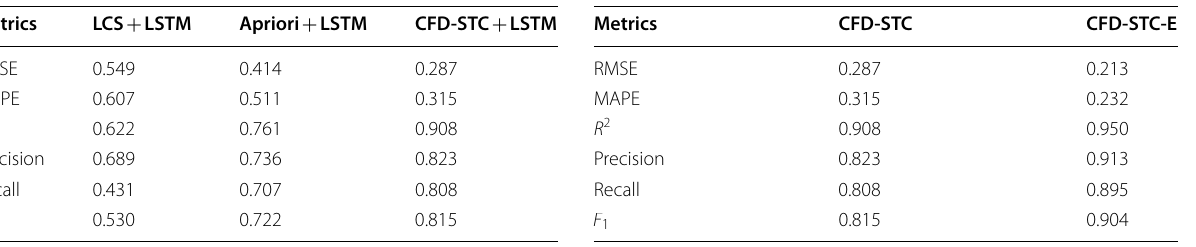
Table 6 The effectiveness of the verification method in the